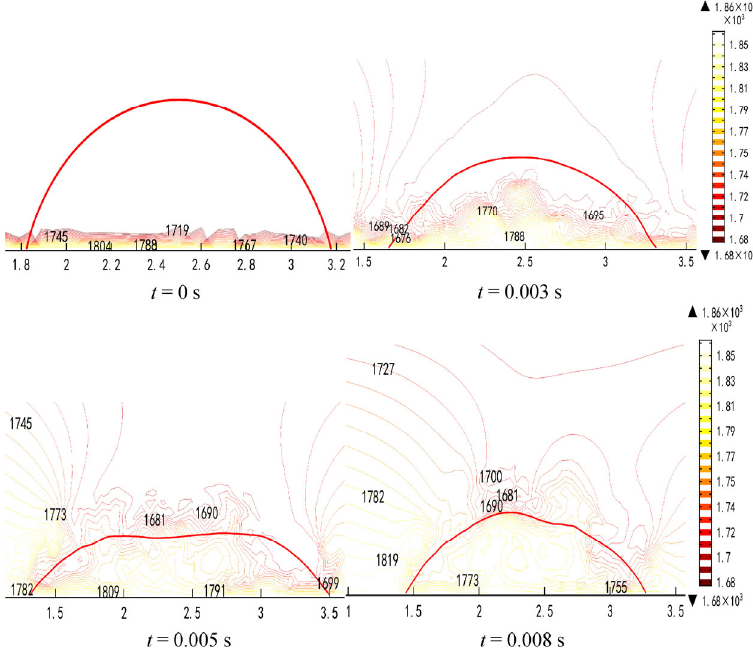
Fig. 12 Variation of T field of molten silicon droplet on graphite substrate ( θ = 45°) during motion process.